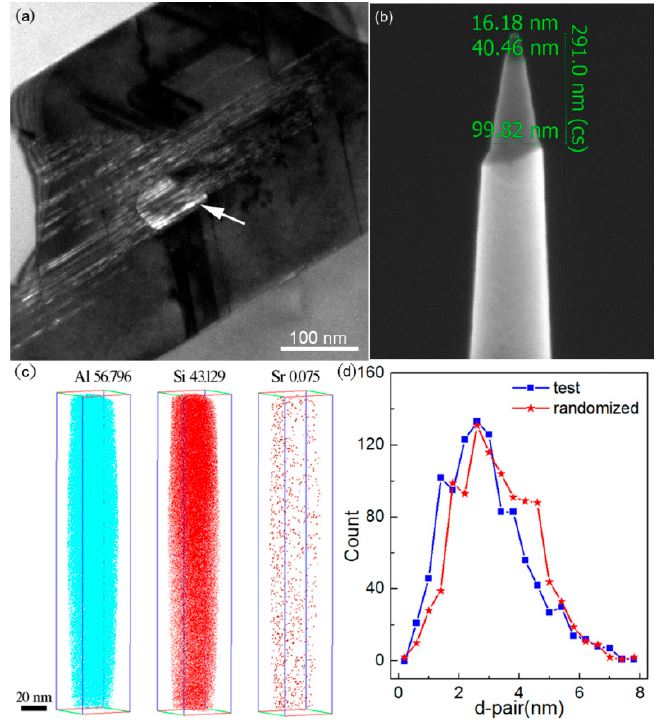
Figure 7. APT results of eutectic Si in Al–10Si–0.35Sb–0.015Sr alloys. ( a ) Large size nanoparticle, ( b ) SEM image of tested tip, ( c ) distribution of atoms in eutectic Si, and ( d ) nearest neighbor distribution of Sr atoms in eutectic Si.